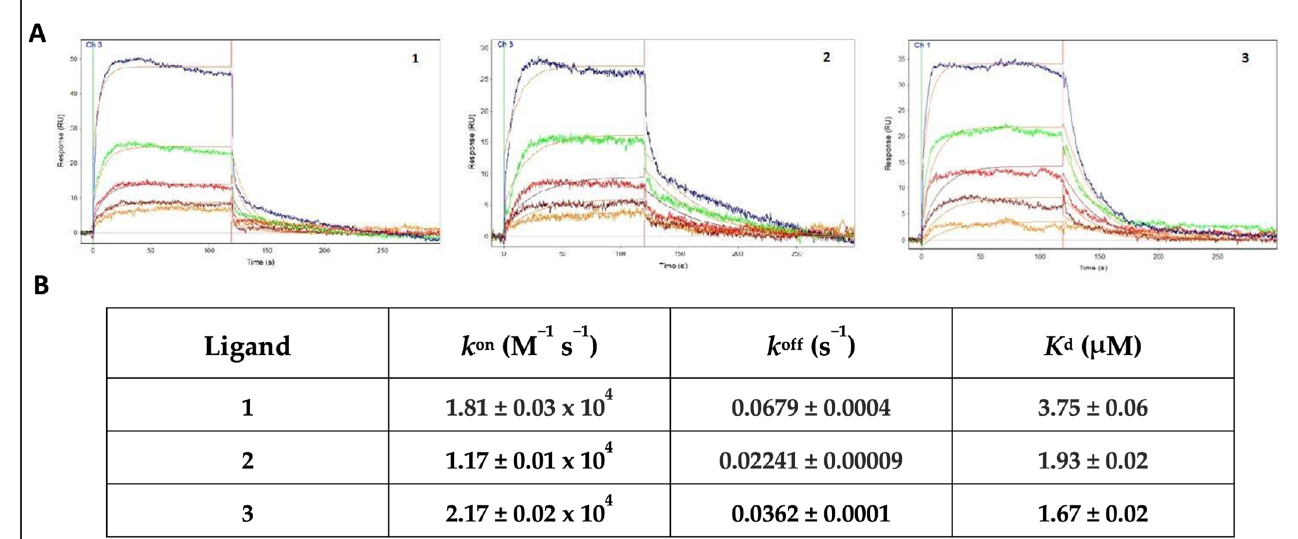
Figure 3. ( A ) Sensorgrams showing the interaction of PPAR γ‐ LBD with different concentrations of 1 , 2 , and 3 (5 µ M blue, 2.5 µ M green, 1.25 µ M red, 625 nM brown, 313 nM orange). Red lines represent the global fits of the data to a 1:1 bimolecular interaction model. K D for PPAR γ /ligands interaction are indicated; ( B ) affinity (K D ) and rate constants (k on and k off ) for PPAR γ /ligand interactions.